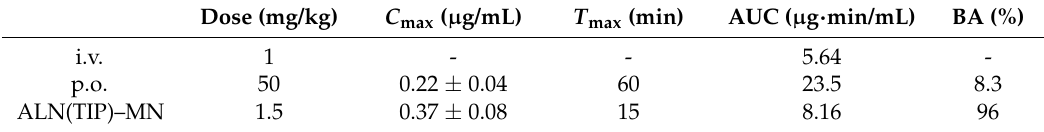
Table 1. Pharmacokinetic parameters of ALN (alendronate) after various administration methods. Dose (mg/kg) C max ( µ g/mL) T max (min) AUC ( µ g · min/mL) BA (%) i.v. 1 - - 5.64 - p.o. 50 0.22 ± 0.04 60 23.5 8.3 ALN(TIP)–MN 1.5 0.37 ± 0.08 15 8.16 96